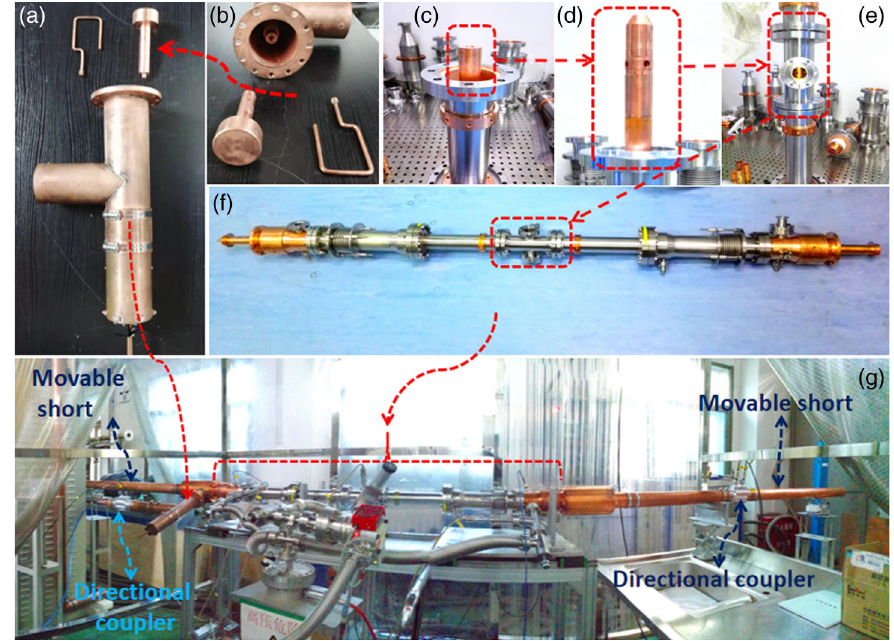
FIG. 15. The proof-of-principle structure of the test system: (a) and (b) show the tunable secondary coupler with the electric probe and magnetic loop; (c) – (f) present the conjunction processes of the two fundamental power couplers; (g) is the overall view of the proof-of- principle structure of the test